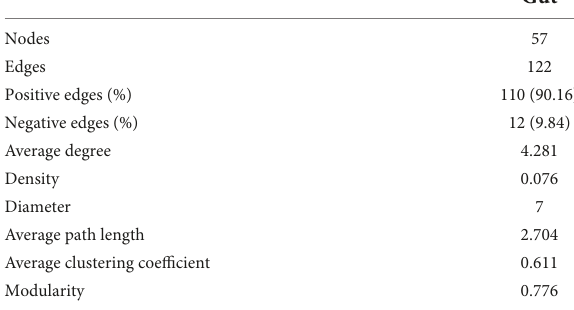
TABLE 4 Topological properties of co-occurring